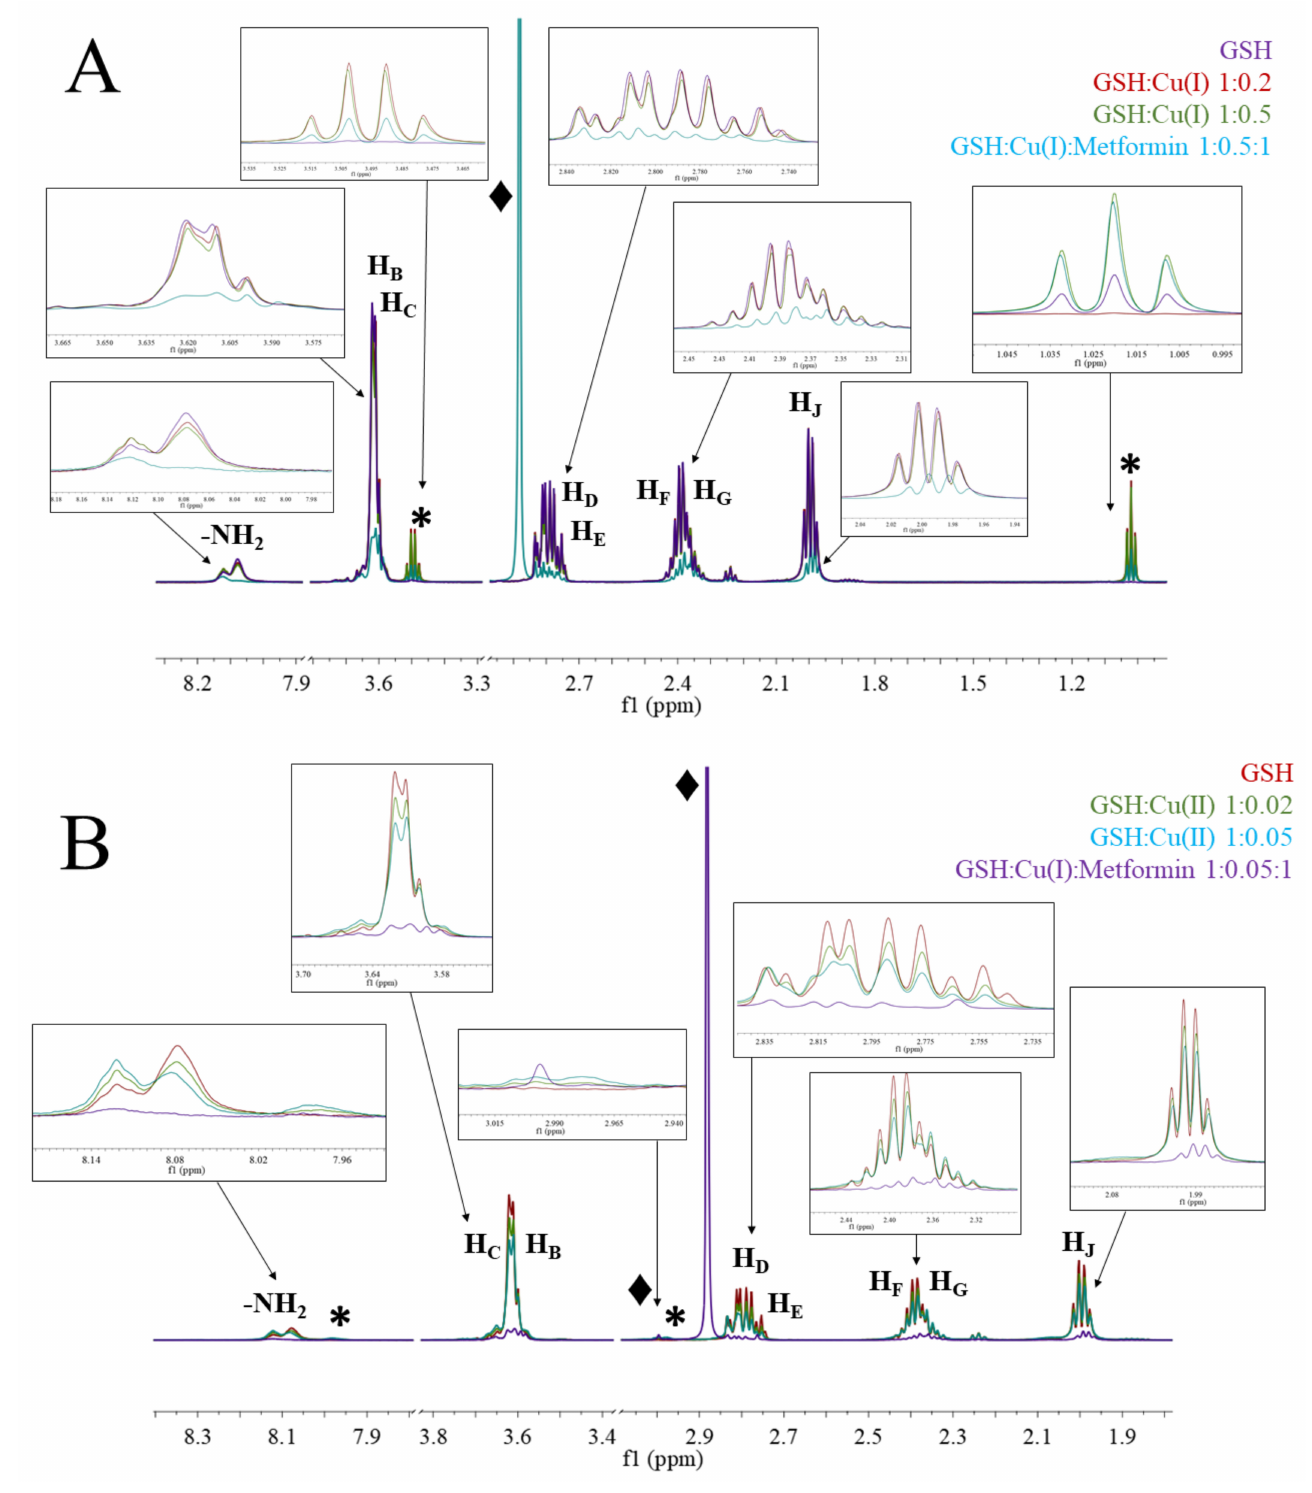
Figure 6. 1 H-NMR spectra of ( A ) GSH; GSH:Cu(I) 1:0.2; GSH:Cu(I) 1:0.5; GSH:Cu(I):metformin 1:0.5:1; ( B ) GSH; GSH:Cu(II) 1:0.02; GSH:Cu(II) 1:0.05; GSH:Cu(II):metformin 1:0.05:1; at pH 7.4 and under argon conditions. The regions’ ppm without signals were removed from the figure for